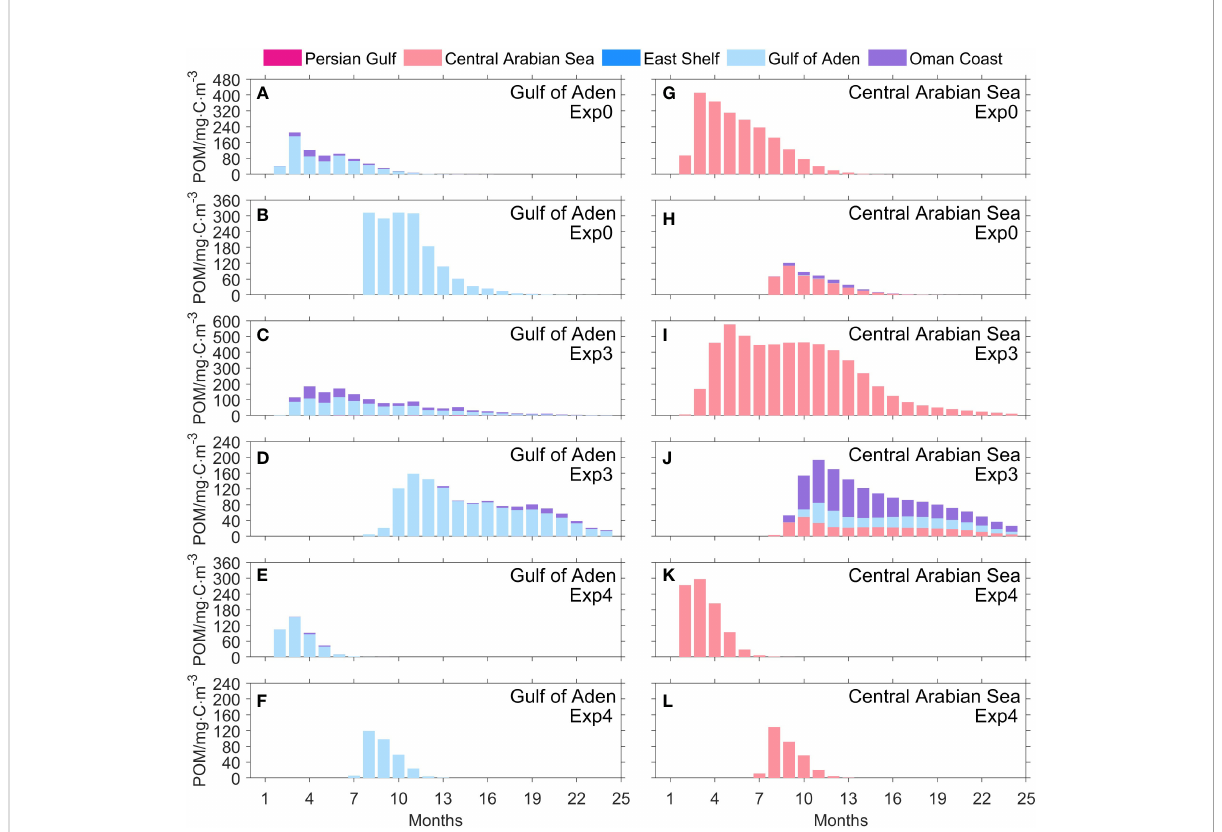
FIGURE 14 Variations and source regions of POM concentration at site A ( A – F ; Gulf of Aden) and site B ( G – L ; central Arabian Sea). POM was released from the fi ve locations (Figure S2) with constant values in different released seasons ( A, C, E, G, I, K , POM released in December; B, D, F, H, J, L , POM released in June). The POM model results were adjusted according to the concentration of chlorophyll in the source